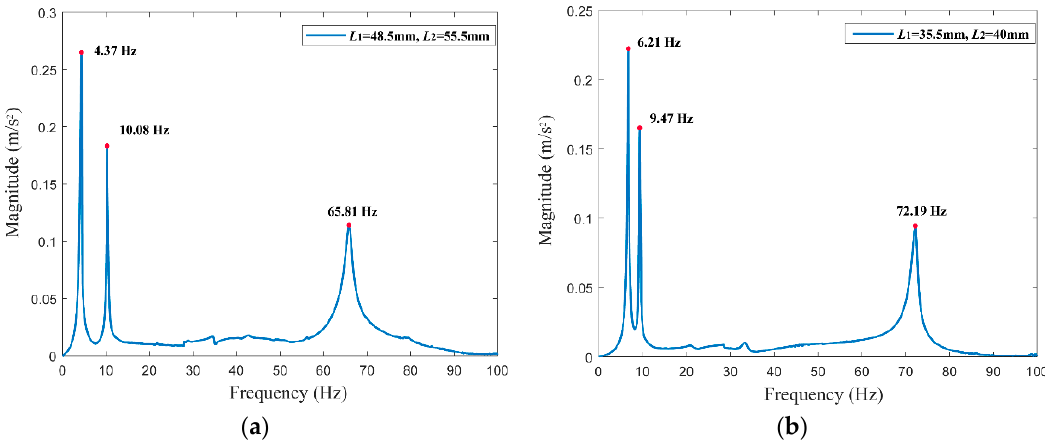
Figure 17. Experimental acceleration responses of the designed TMDs. ( a ) TMD1; ( b ) TMD2.